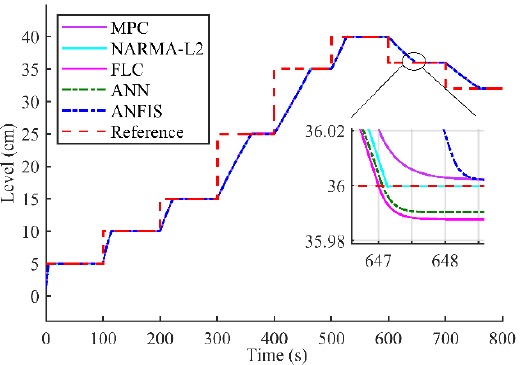
Figure 15. Results of liquid level control in the spherical tank compared to the variable reference value.